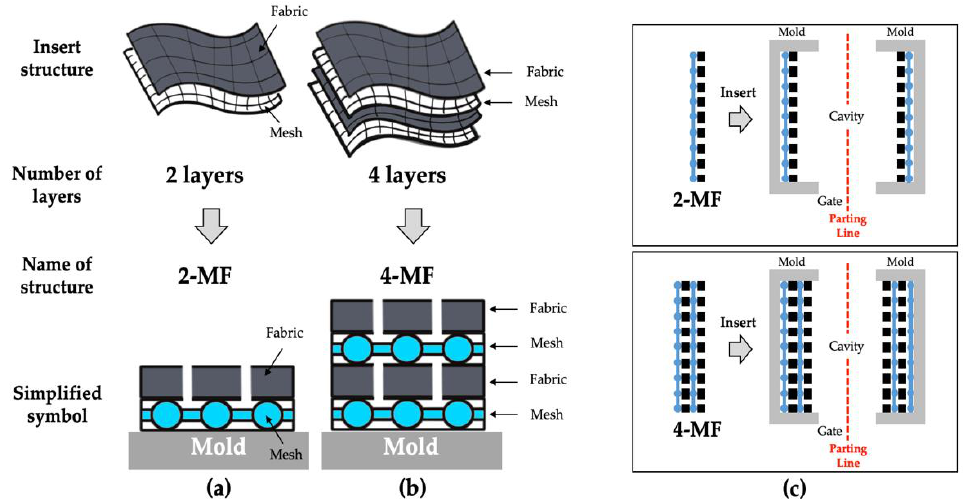
Figure 7. Schematics of the insert structures: ( a ) 2-MF structure; ( b ) 4-MF structure; ( c ) mold insert structure. Table 4. Injection molding conditions for the mesh-inserted composite.